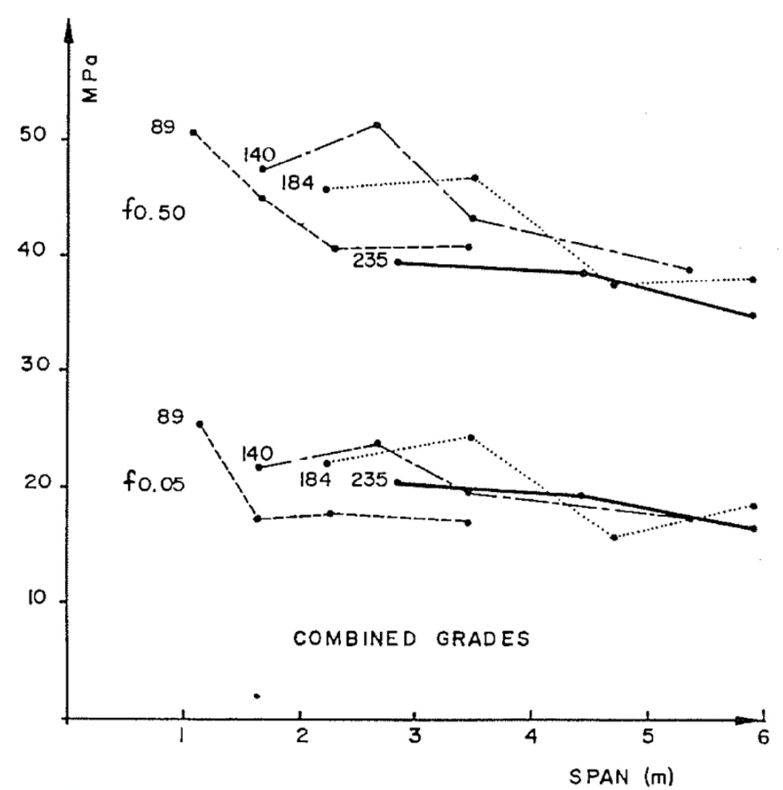
Figure 43. Fifth and fiftieth percentile strength data obtained from three-point loading of Hem-Fir wooden beams of the same span-to-depth ratio, but with different depths. These data were obtained in 1976. From [86].